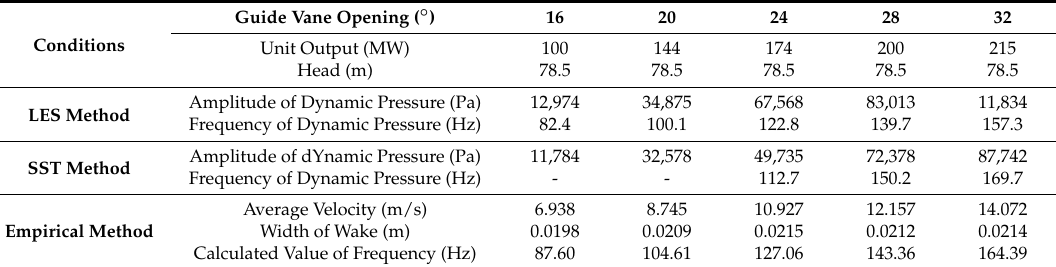
Table 4. Comparison of results obtained by different methods.